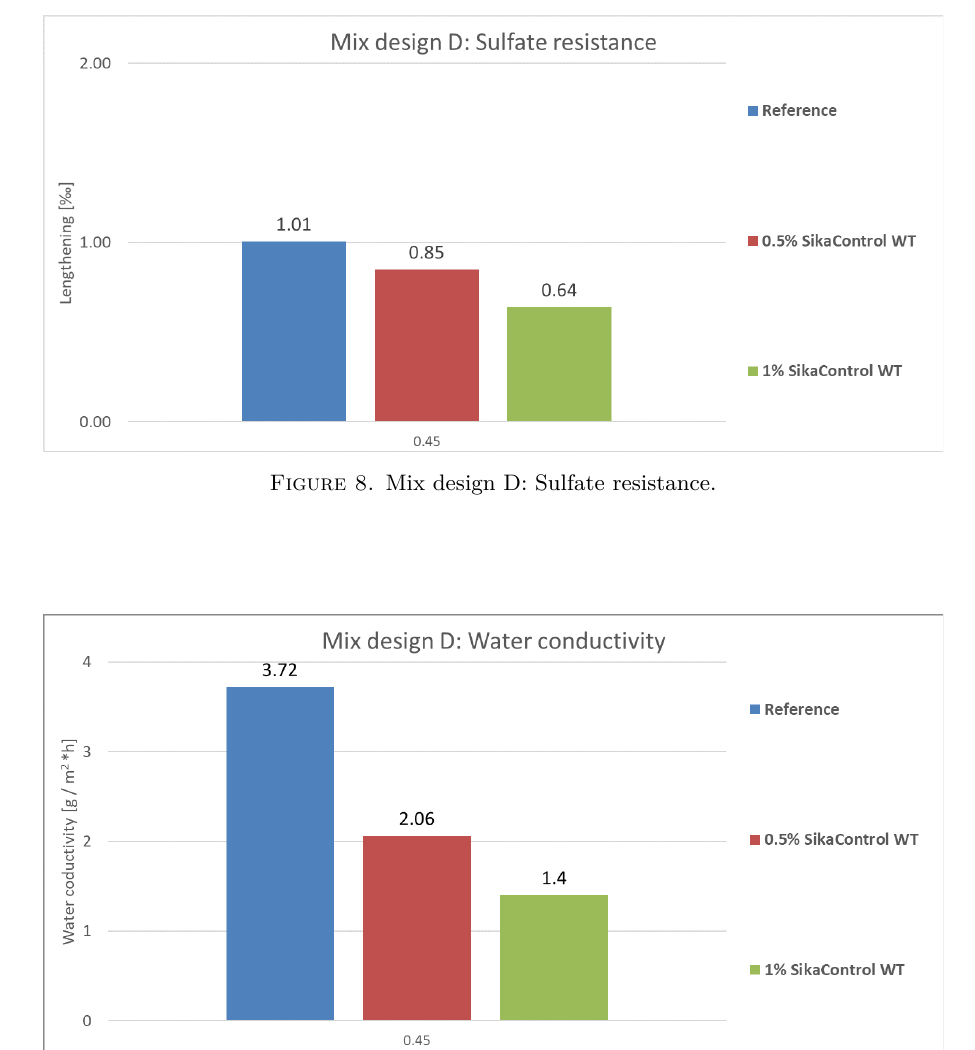
Figure 9. Mix design D: Water